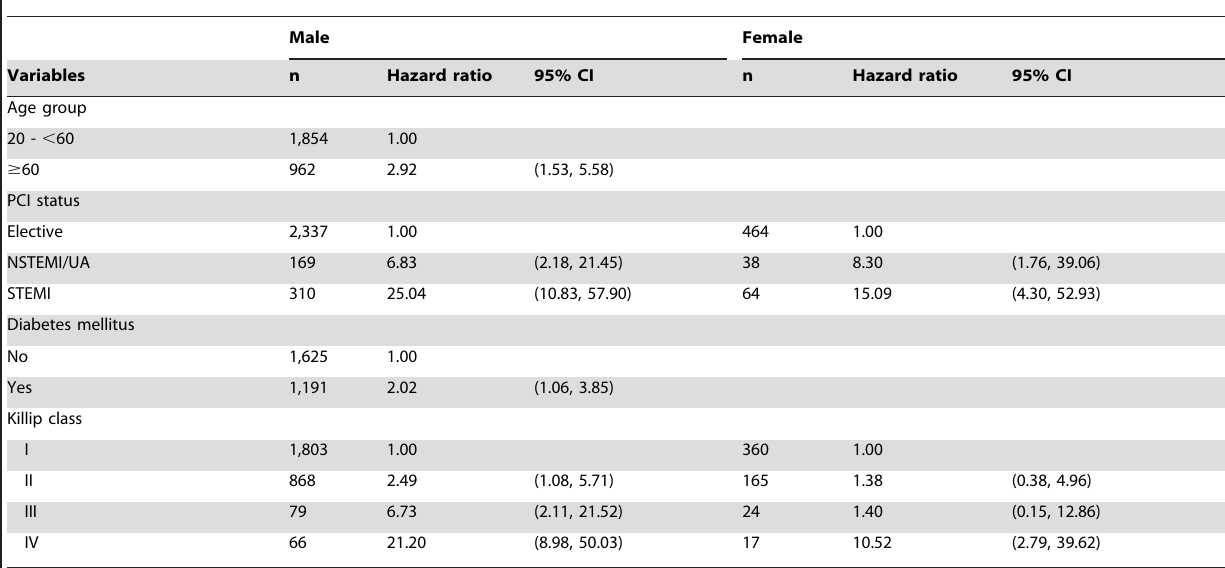
Table 6. Prognostic factors for in-hospital mortality by